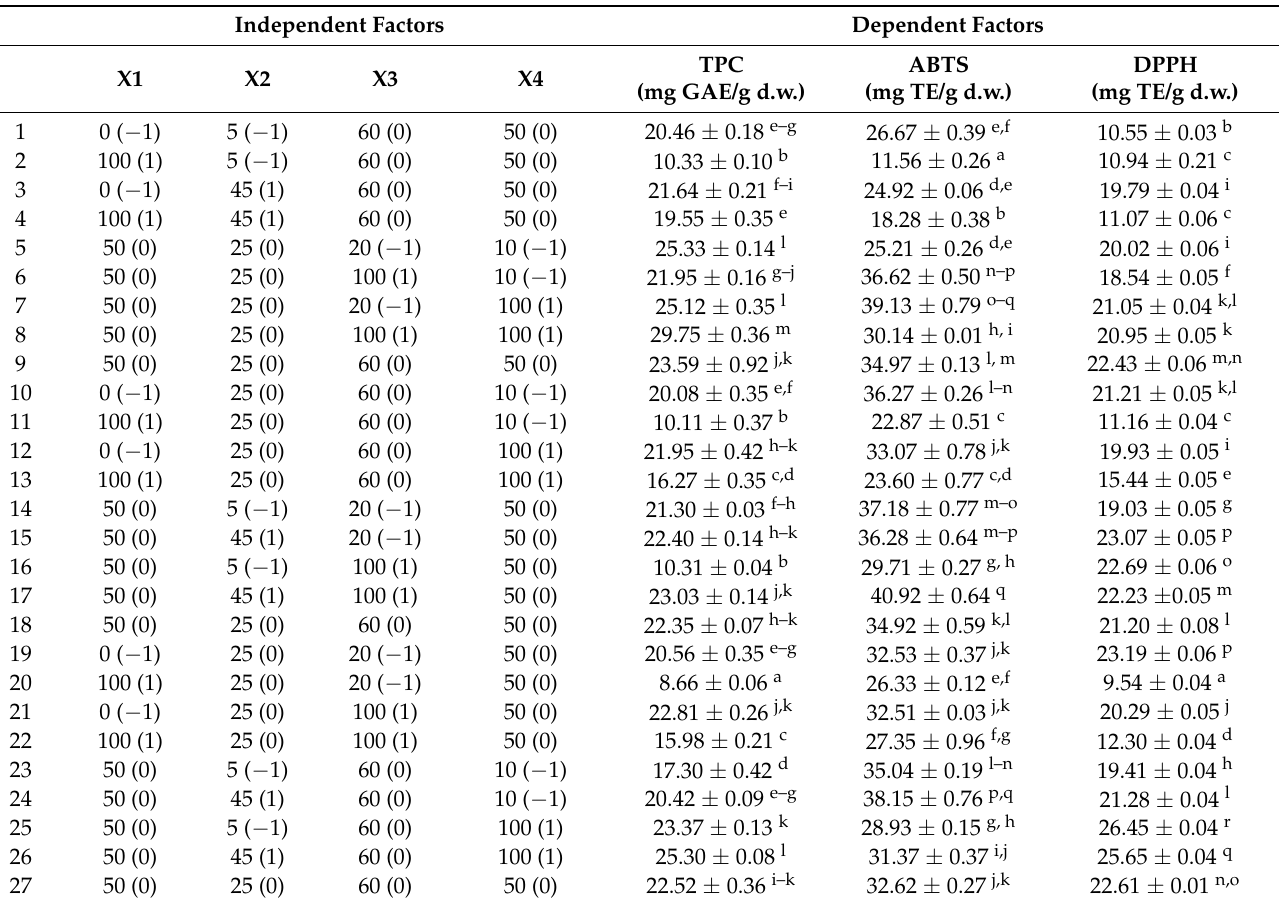
Table 1. Box–Behnken design with natural and coded values (parenthesis) of the conditions of extraction and the ex- perimental results obtained for TPC, and antioxidant assays (ABTS and DPPH) expressed with the average and the standard